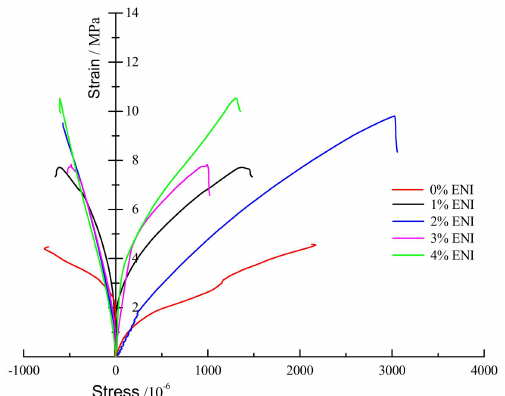
Figure 2. Uniaxial compression stress–strain curve of carbonaceous